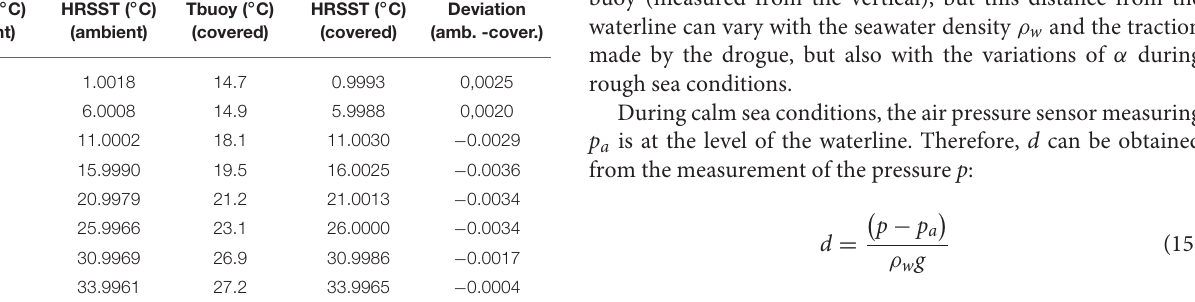
TABLE 3 | Differences between buoys and HRSST ambient and covered temperatures for the buoy n ◦ Y17-07. Tbuoy ( ◦ C)